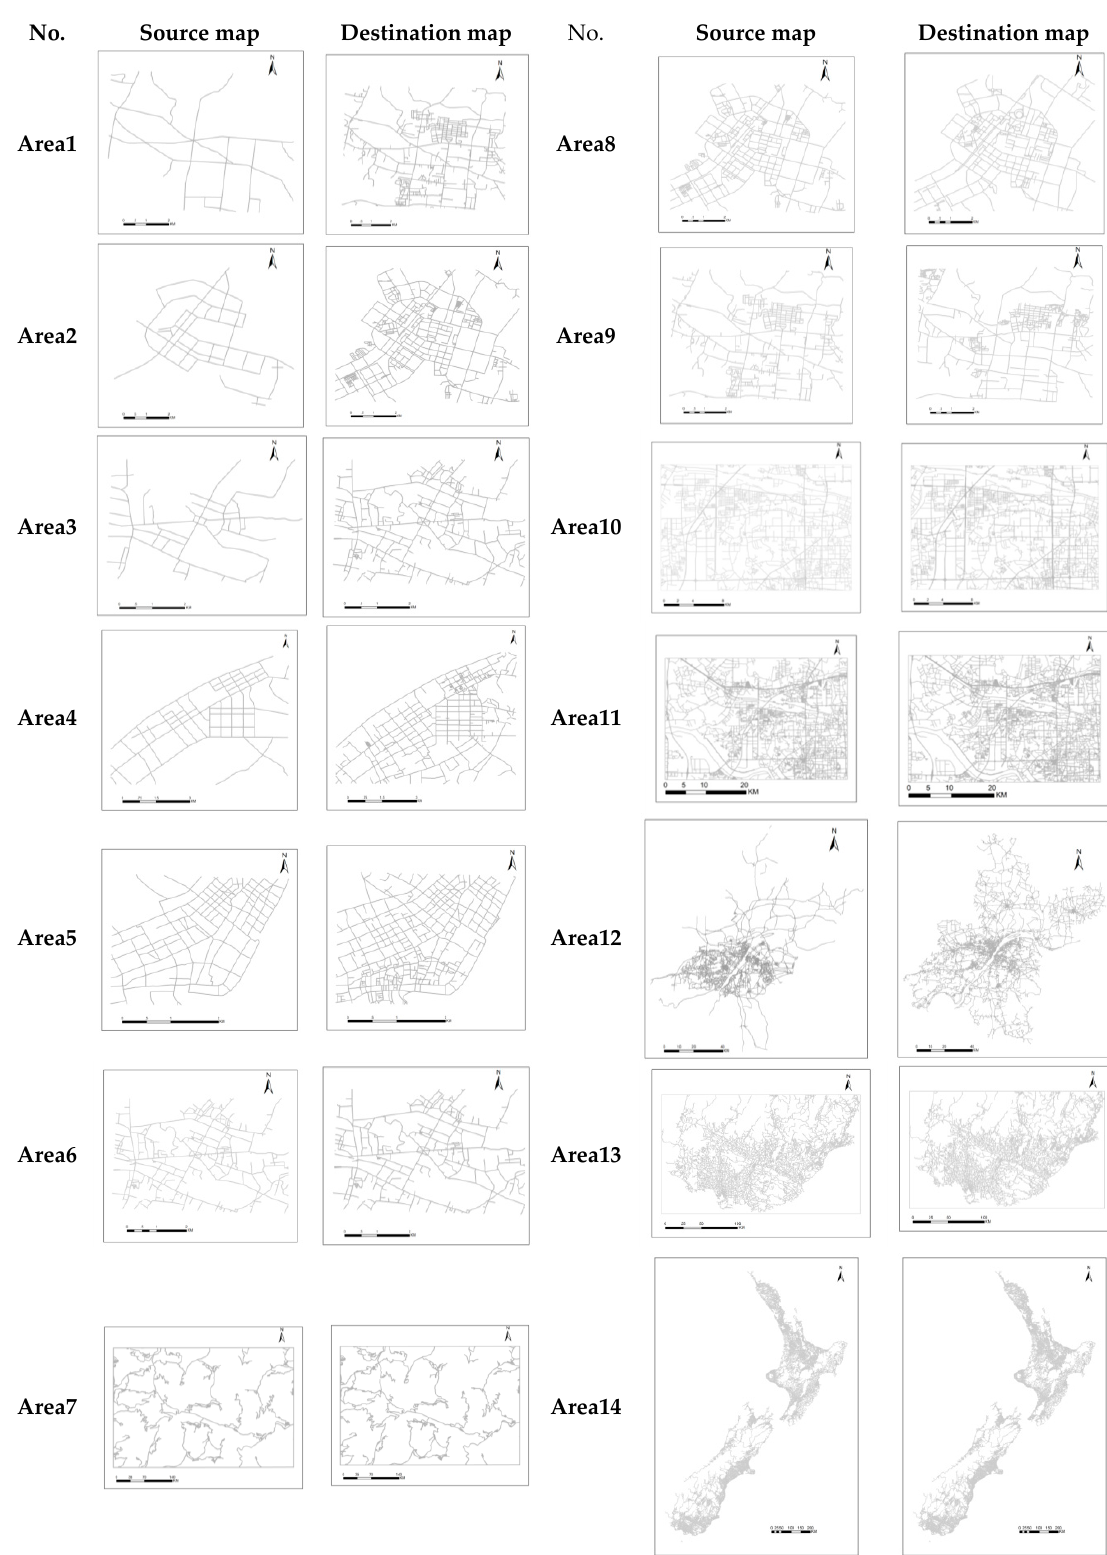
Figure B1. Road networks used for testing. Figure A1. Road networks used for